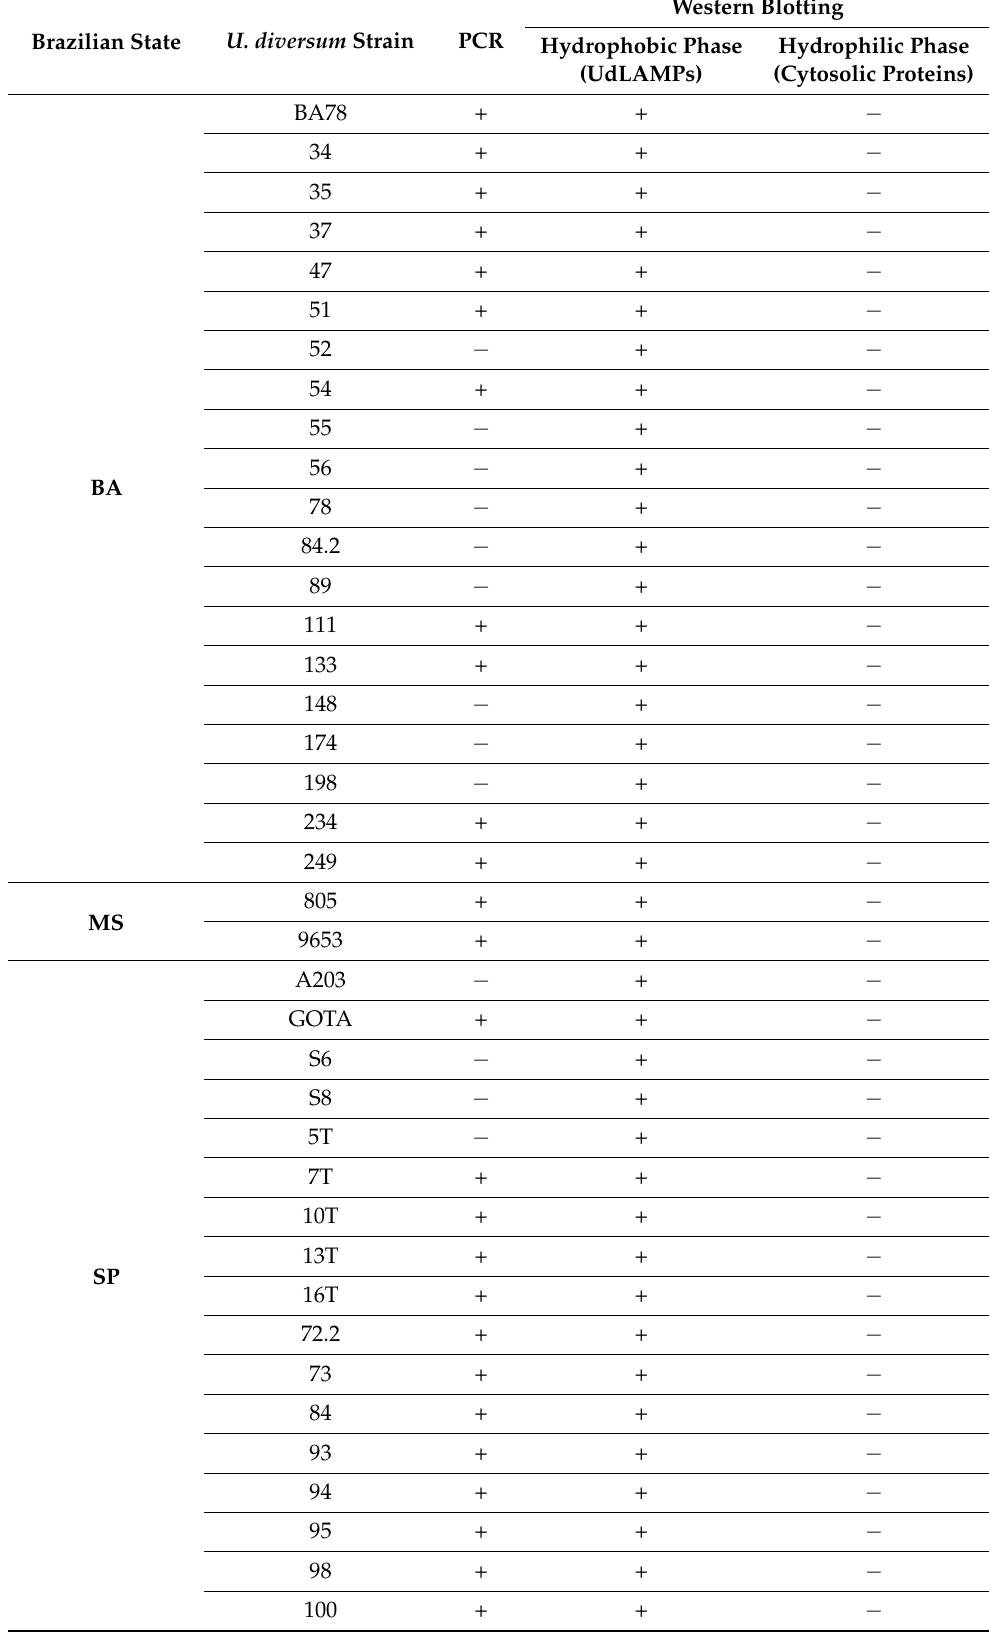
Table 1. PCR and Western blotting of Ureaplasma diversum from different Brazilian